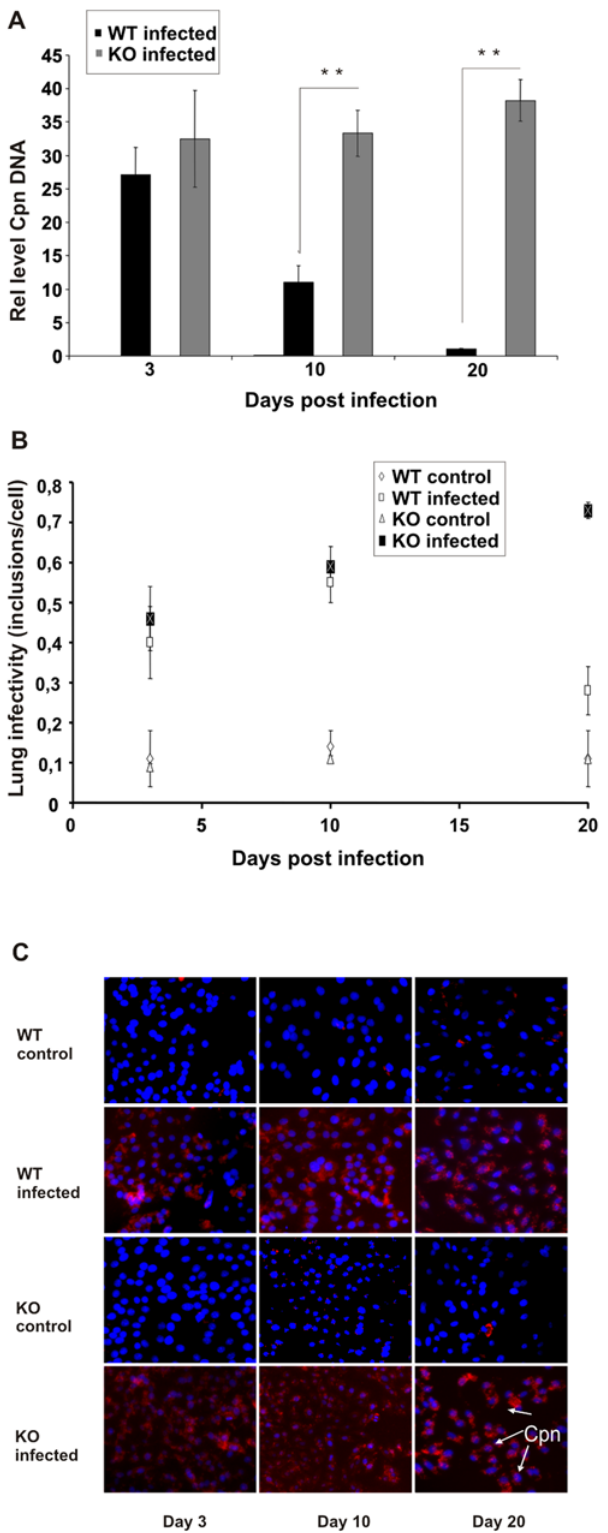
Figure 1. Sensitization of cIAP-1 KO mice for C.pneumoniae lung infection. A. Five mice per group were infected with C. pneumoniae and the chlamydial omp A gene was amplified from the lung tissue of each mouse (as described in Supporting Materials and Methods S1). The relative amount of the omp A gene in each